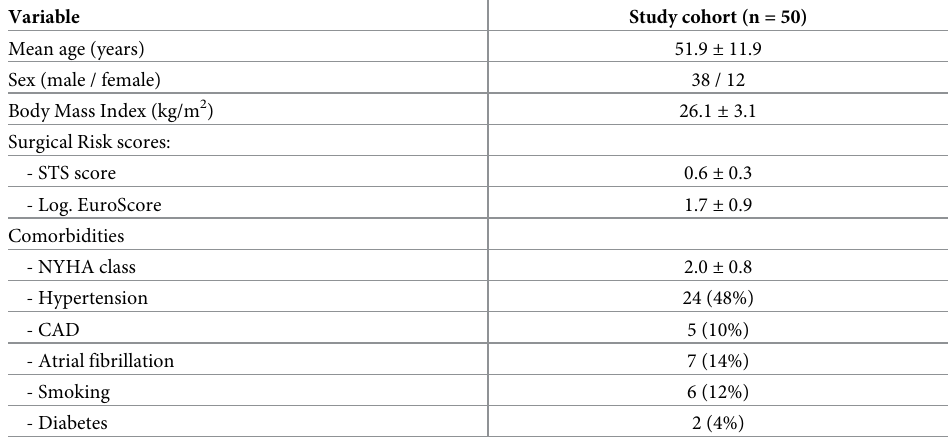
Table 1. Demographics and baseline variables. Values are presented as numbers (proportion) or as mean ± SD. CAD- coronary artery disease, NYHA–New York Heart Association functional